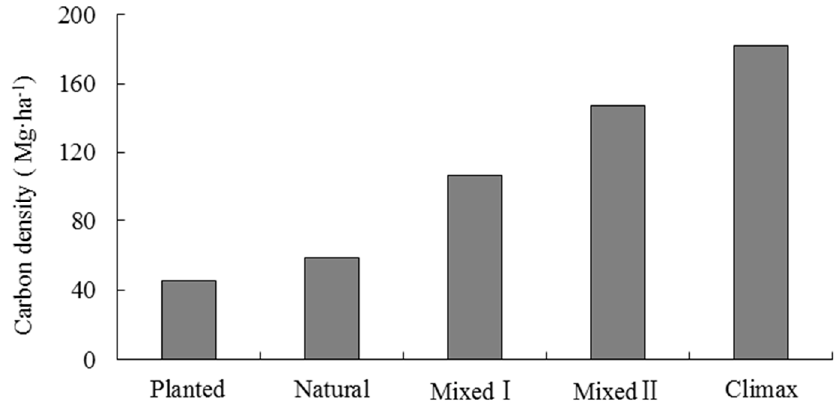
Figure 4. Vegetation carbon density (including tree, understory vegetation and litter layers) of various successional forests in the study subtropical region. Mixed I denotes mixed forests that are Pinus massoniana -dominant, while Mixed II denotes mixed forests that are broadleaf-dominant [37,38].